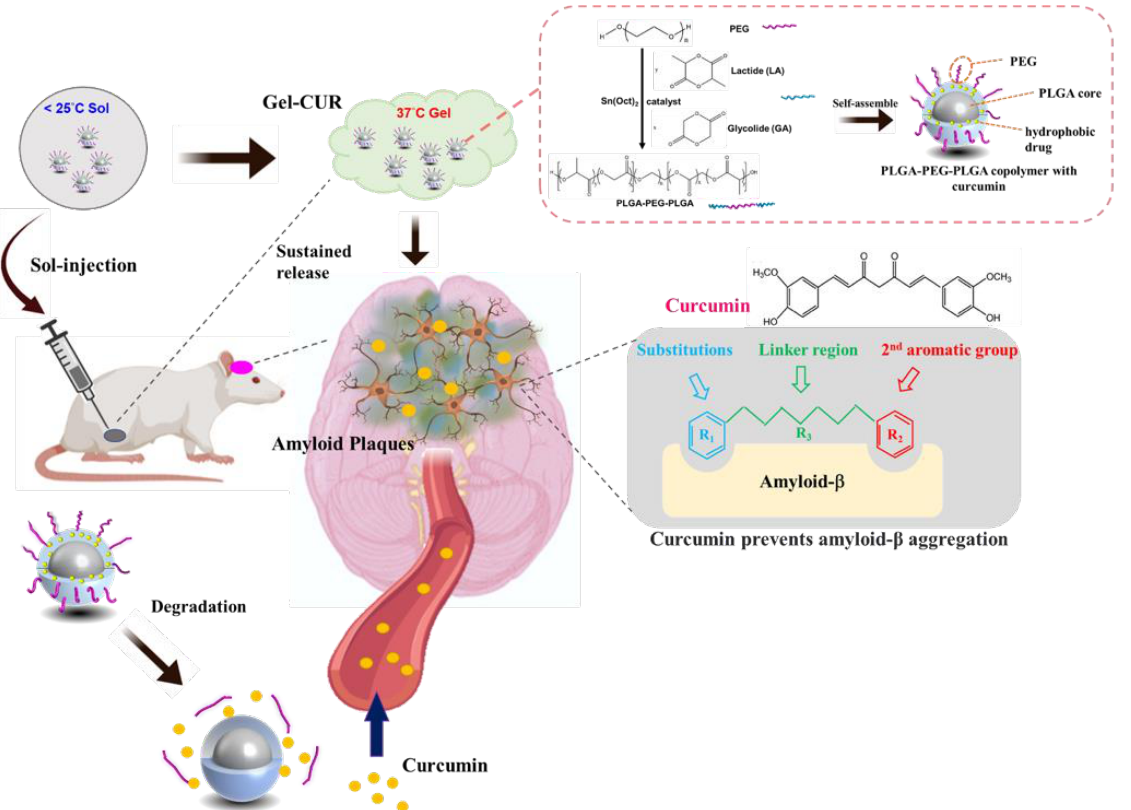
Figure 1. The scheme of the experimental design. This study used the N2a cell line as an in vitro model to investigate the decrease in amyloid- β plaque by a PLGA-PEG-PLGA thermo-sensitive hydrogel with curcumin (PGC) for intramuscular injection. This was to achieve continuous release of curcumin and maintain a constant level of curcumin in the blood, thus preventing Alzheimer’s disease (AD) development or progression. In addition to the in vitro model, an AD rat model was induced by intraperitoneal injection of AlCl 3 three times a week. The Morris water maze and functional MRI were then used to assess the rats’ working and spatial memory retention. Finally, a biochemical analysis was used to evaluate the effect of AD prevention by PGC.